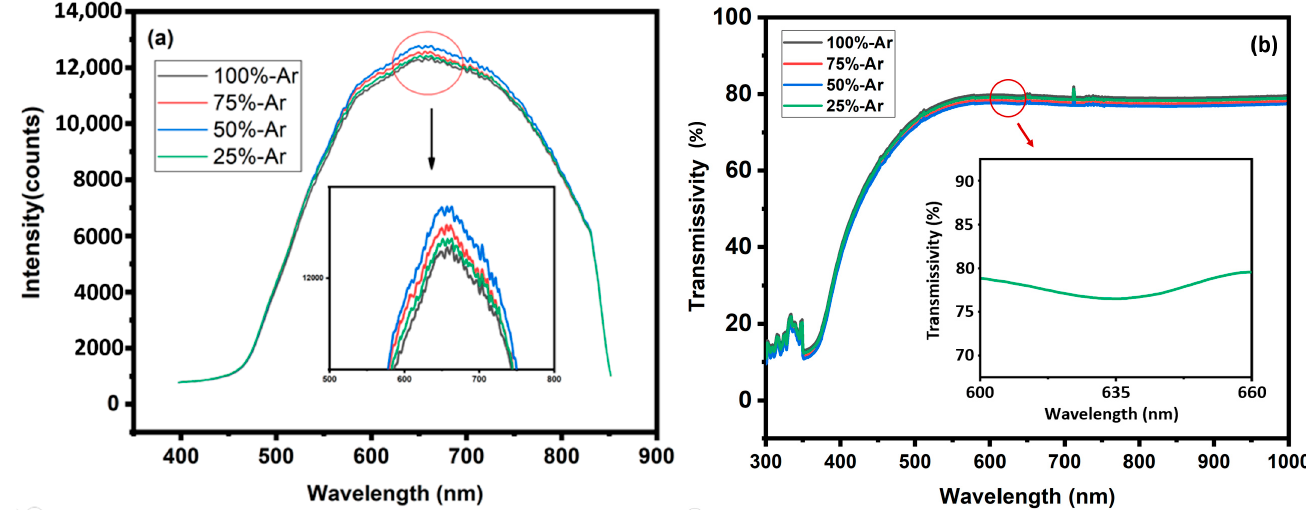
Figure 2. The absorption and transmission spectrum of the IGZO at the different deposition atmos- pheres. ( a ) Absorption spectrum, Inset: the enlarged area of the red part; ( b ) Transmission spectrum, Inset: the enlarged area of the red circular in range of 600–660 nm.